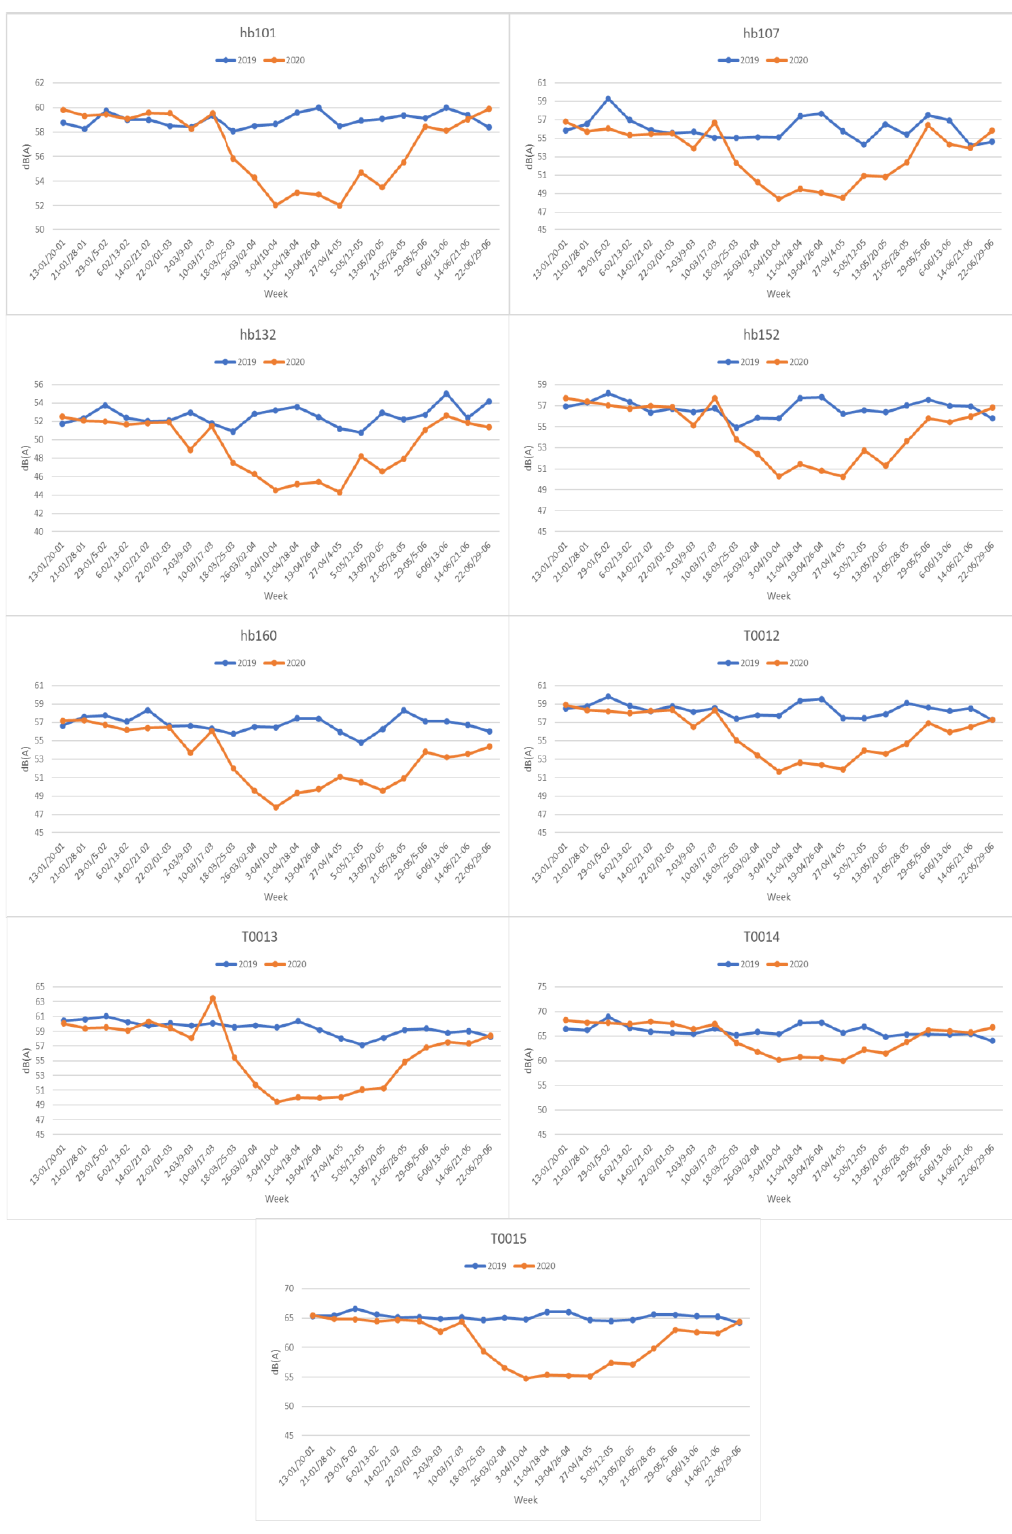
Figure 12: Comparison between weakly average Lden values for 2019 and